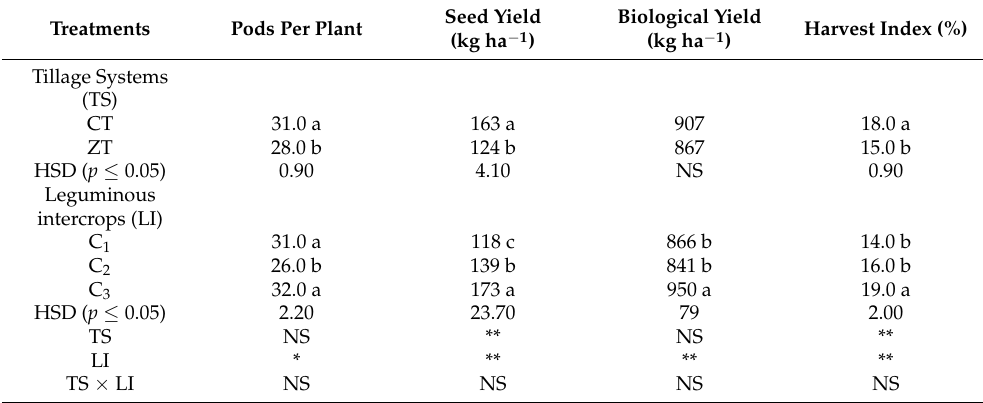
Table 2. Effect of different tillage systems and legume intercrops on pods per plant, seed yield, biological yield, and harvest index of leguminous intercrops.